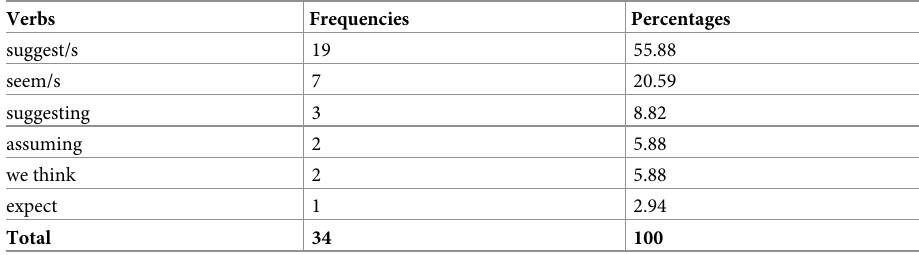
Table 9. Frequencies and percentages of verbs in the simple present.